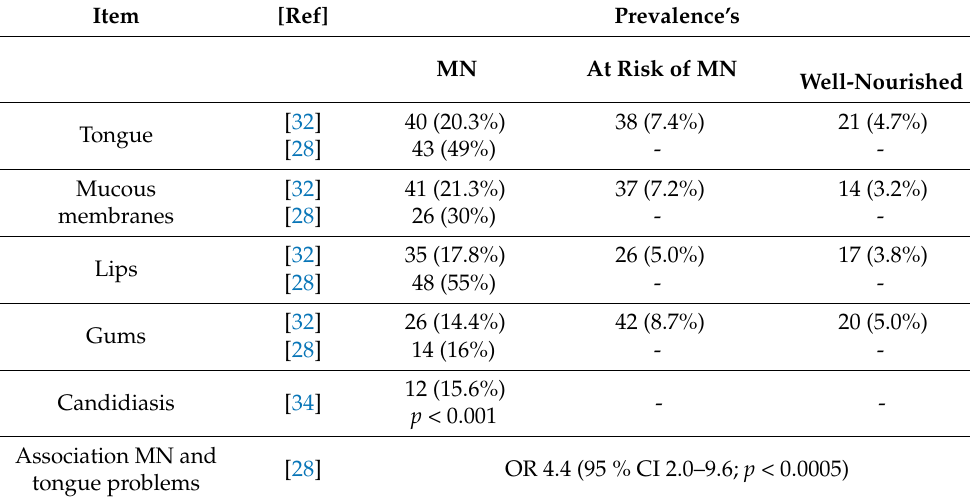
Table 3. Outcome measures regarding soft tissue conditions in malnourished older people compared to well-nourished older